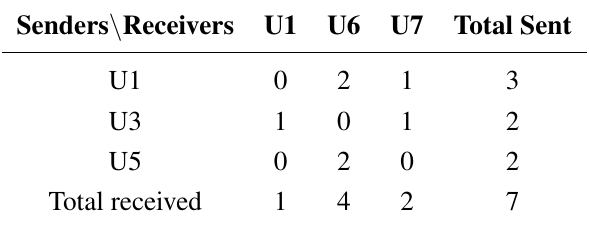
Table 1. Example of a contingency